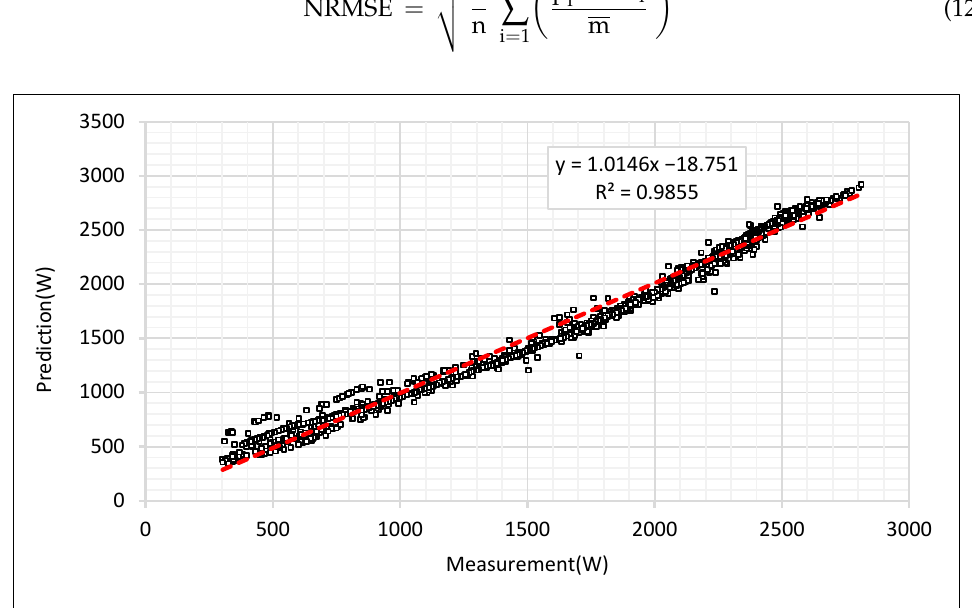
Figure 5. Comparison between predicted and measured power.